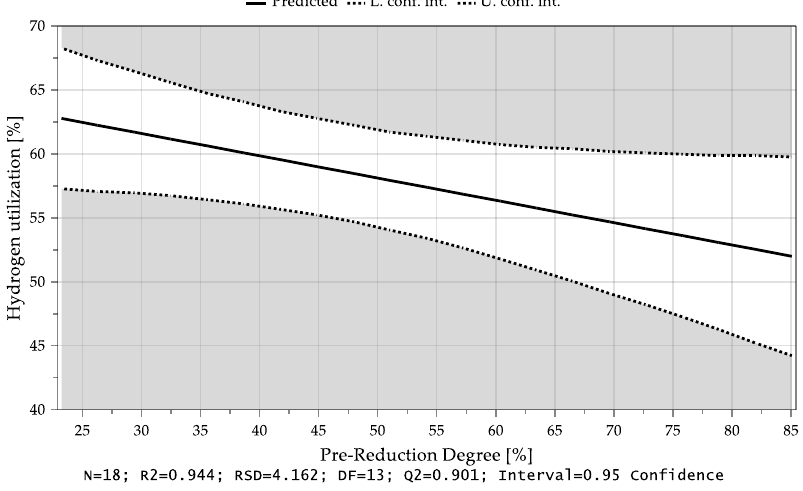
Figure 16. Hydrogen utilization as a function of the Reduction Degree during iron ore feeding.